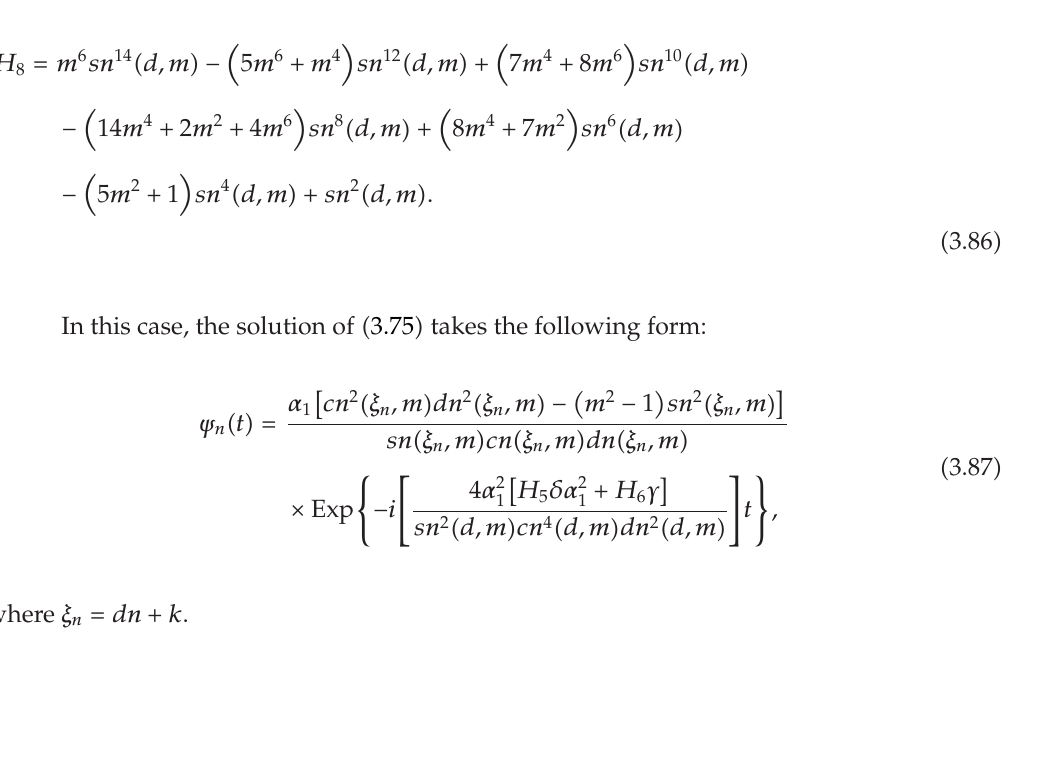
Figure 4: (cid:5) a (cid:6) and (cid:5) b (cid:6) represent the Jacobi elliptic solution (cid:5) 3.84 (cid:6) when m (cid:9) 0 . 5, α 1 (cid:9) 0 . 6, k (cid:9) 0 . 2, δ (cid:9) 0 . 4, γ (cid:9) 0 . 1, d (cid:9) 0 . 3, n (cid:9) 2. (cid:5) c (cid:6) and (cid:5) d (cid:6) represent the Jacobi elliptic solution (cid:5) 3.84 (cid:6) when m (cid:9) 0 . 5, α 1 (cid:9) 0 . 6, k (cid:9) 0 . 2, δ (cid:9) 0 . 4, γ (cid:9) 0 . 1, d (cid:9) 0 . 3, t (cid:9) 1 .